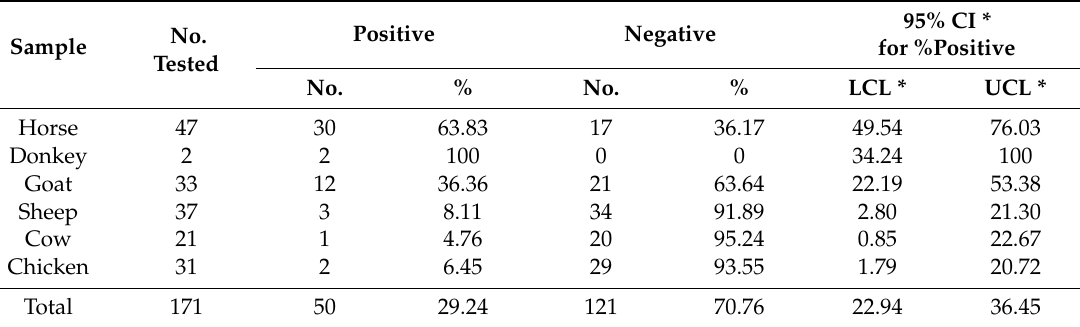
Table 4. The prevalence of TTV in domestic farm